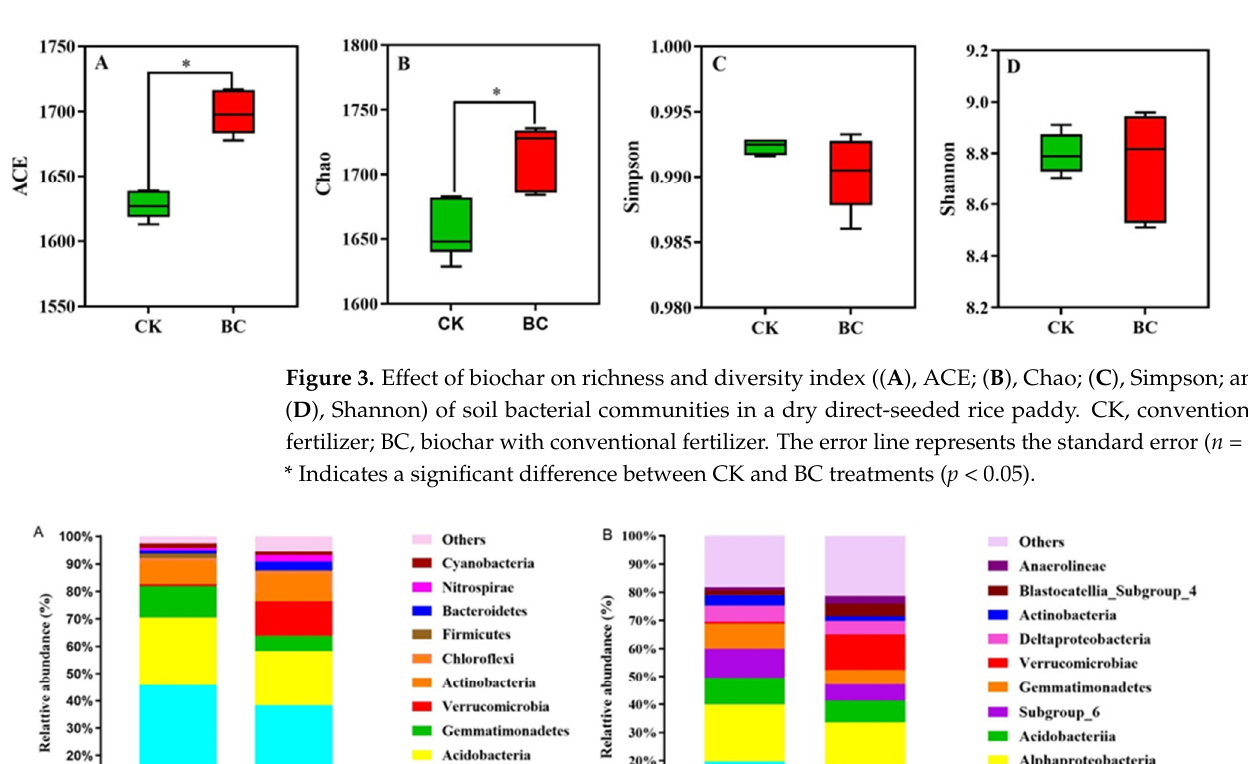
Figure 3. Effect of biochar on richness and diversity index (( A ), ACE; ( B ), Chao; ( C ), Simpson; and ( D ), Shannon) of soil bacterial communities in a dry direct-seeded rice paddy. CK, conventional fertilizer; BC, biochar with conventional fertilizer. The error line represents the standard error ( n = 6). * Indicates a significant difference between CK and BC treatments ( p < 0.05).